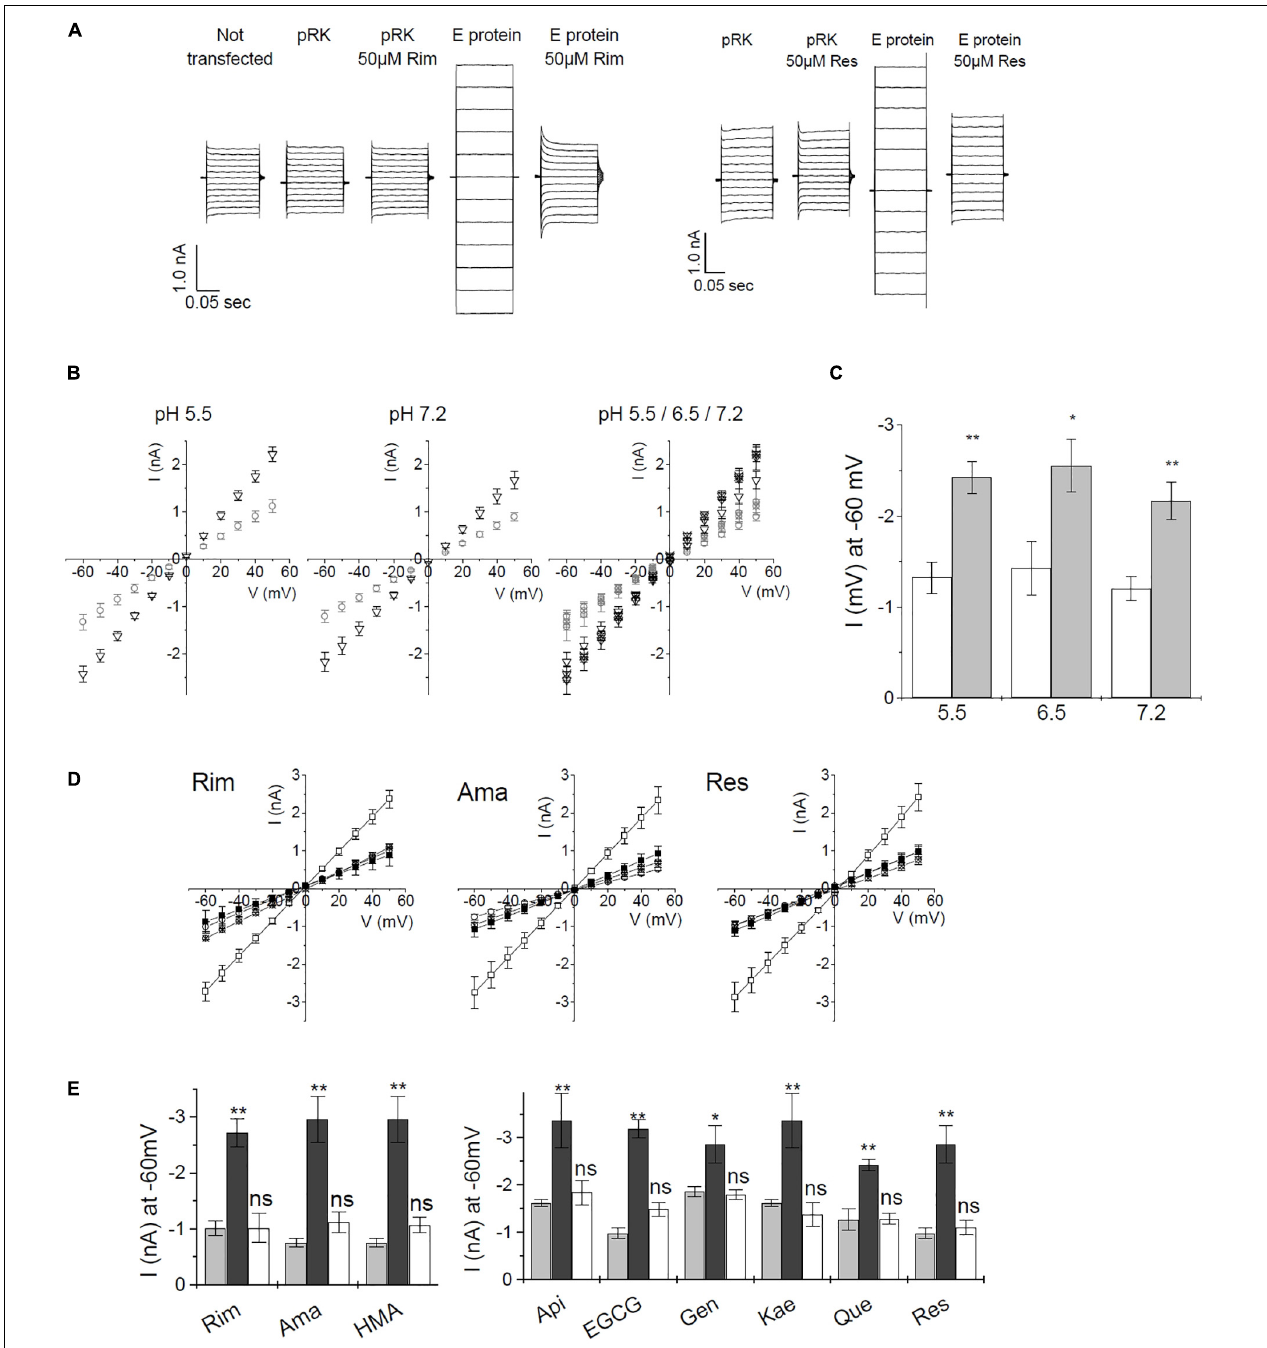
FIGURE 5 | Current–voltage recordings from recombinant SARS CoV E protein in HEK293 cells. (A) Direct currents from a voltage ramp from –60 to +50 mV. Controls were (i) untransfected cells, (ii) mock (empty pRK vector) transfected HEK293 cells. Left panel: inhibition by rimantadine, right panel: inhibition by resveratrol. (B) pH dependence of control cells and E protein expressing HEK293 cells using standard extracellular buffer. Left and middle panel: open circles: control cells; open triangles: E protein expressing cells. Right panel: open symbols: pH 7.2; symbols including +: pH 6.5; crossed symbols: pH 5.5. Left and middle panel: pH 5.5 and 7.2, respectively. Right panel: summary of currents at pH 5.5, 6.5, and 7.2. Induced currents over the investigated pH range were not significantly different. (C) pH dependence of E-protein-mediated currents at –60 mV. White bars: pRK control; gray bars: currents induced after E protein expression. (D) Inhibition of E-protein channels by rimantadine, amantadine, and resveratrol. Open symbols: no inhibitor, solid symbols: in presence of 20 µ M of inhibitor; circles: control (empty pRK) cells; squares: E protein expressing cells. (E) Summary of inhibition data. Light gray columns: control currents (pRK); dark gray columns: E-protein expressing cells; white columns: E-protein currents in the presence of inhibitor (20 µ M). Significance was determined using one-way ANOVA with * p < 0.05; ** p < 0.01, n.s. = not significant. See Supplementary Figure 2 for a complete set of inhibition data.